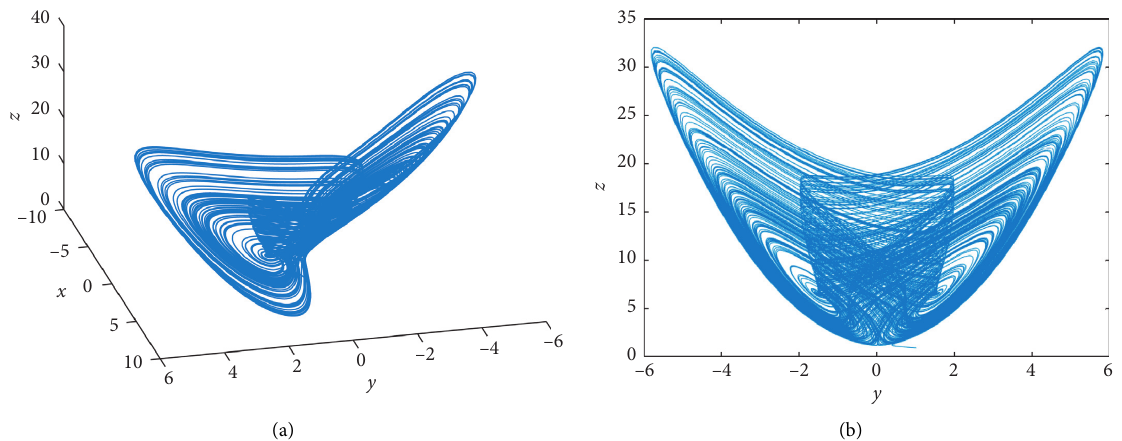
Figure 19: Phase portraits of the fractional system with k � 5 and α � 0 . 95.